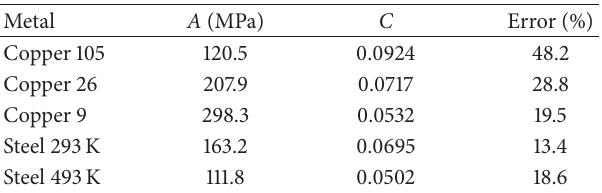
Table 2: Material constants and errors obtained with the standard Johnson-Cook equation.